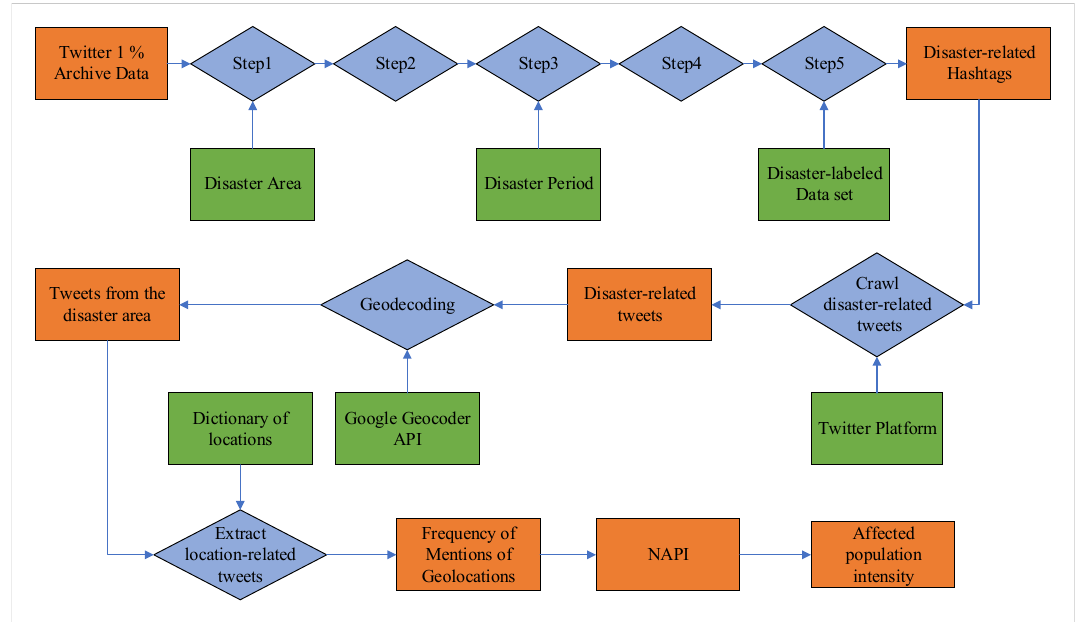
Figure 1. Flowchart of the assessment of the affected population intensity using social